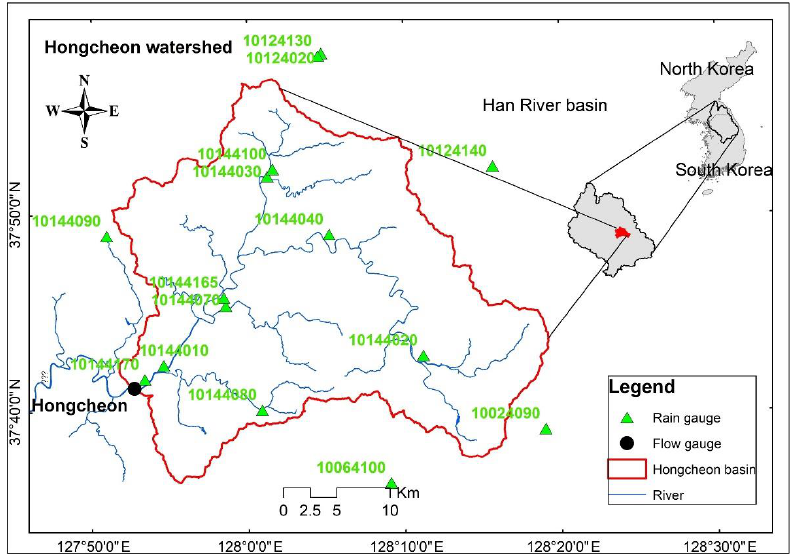
Figure 1. The “Hongcheon” watershed belonging to Han river basin, and the locations of observed rainfall and flow gauges. Table 1. Characteristics of selected streamflow events.